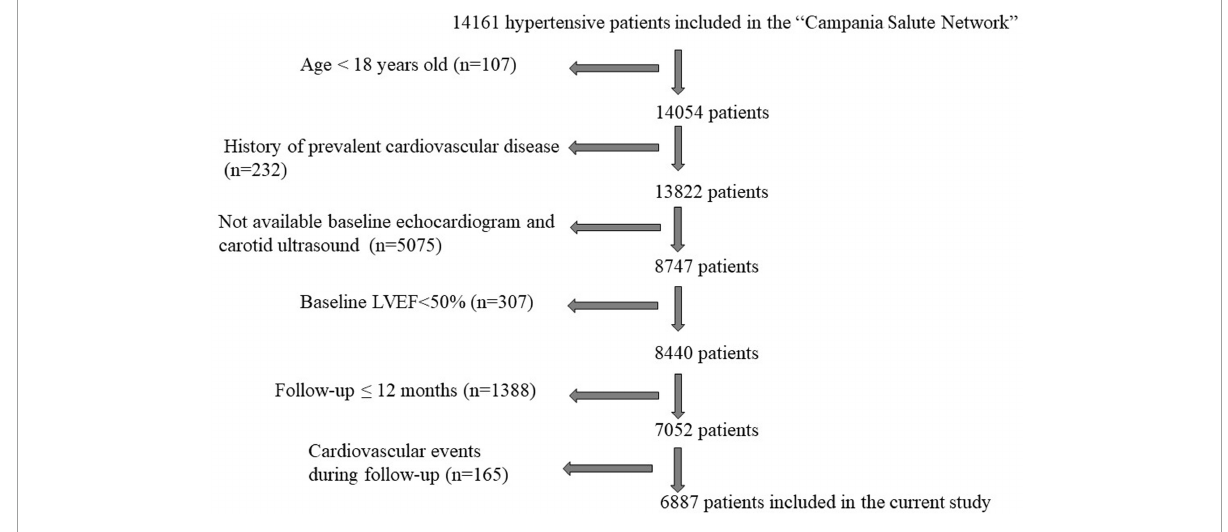
FIGURE1 Flow chart describing the selection of hypertensive patients from the “Campania Salute Network” for the present study. LVEF, left ventricular ejection fraction.